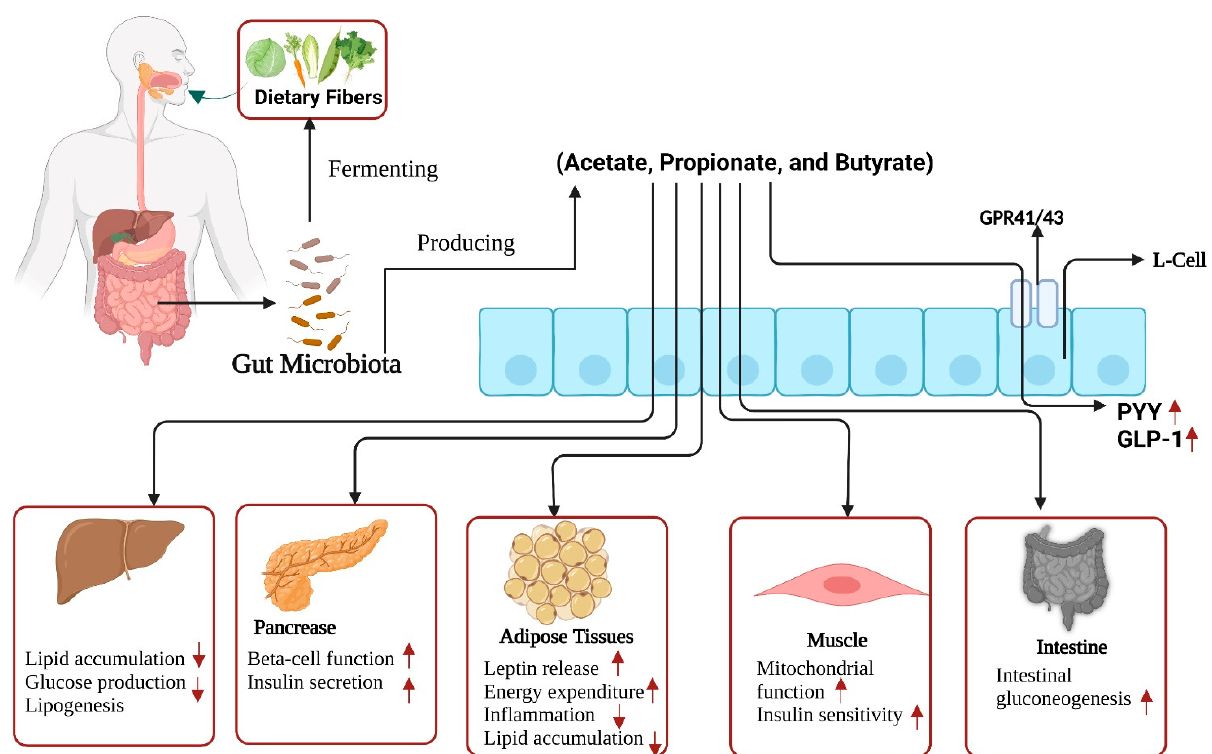
Figure 3. Gut microbiota ferments dietary fiber and produces short-chain fatty acids (SCFAs) acetate, propionate, and butyrate. These SCFAs may facilitate the production/release of GLP-1 and PYY from enteroendocrine (L-cells) and activate adipose tissue to release leptin hormone. These fatty acids also enhance insulin sensitivity and mitochondrial functions in muscle cells, promote pancreatic functions, including insulin secretion and beta cell activity, and promote intestinal gluconeogenesis. In the liver, lipid accumulation, and glucose production are reduced. Arrows pointing upwards indicate an increase, and arrows pointing downwards indicate a decrease. Abbreviations: PYY; peptide YY: GLP-1; glucagon-like peptide-1: GPR-41; G-protein receptors-41: GPR-43; G-protein